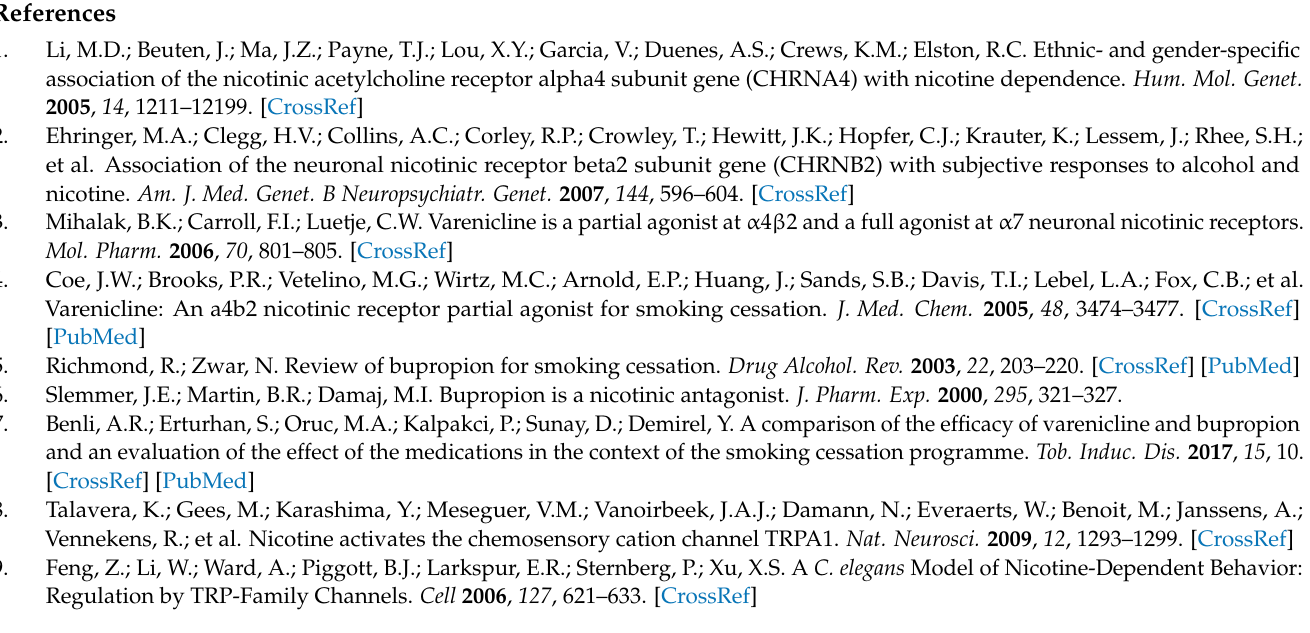
Table S2: Stability in mouse liver